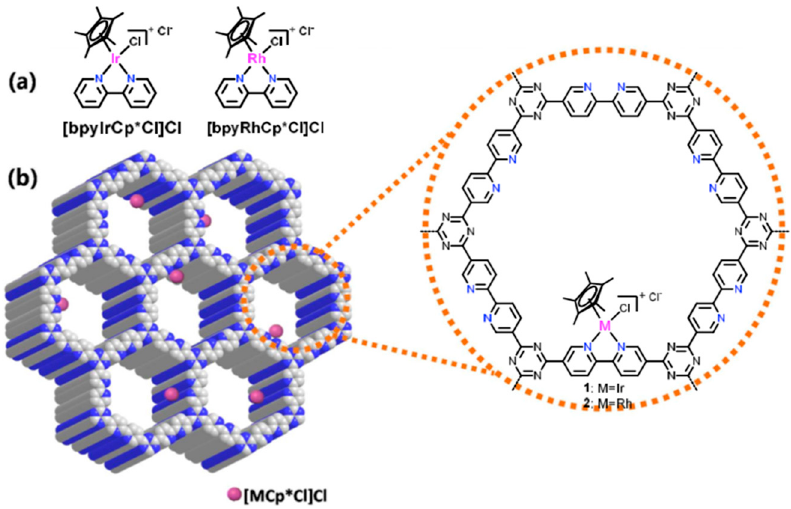
Figure 6. Structural representation of ( a ) homogeneous Ir- and Rh-based catalysts, and ( b ) CTF- Structural representation of ( a ) homogeneous Ir- and Rh-based catalysts, supported catalysts (Adapted with permission from [50]. Copyright 2016, Royal Society of Chemistry).